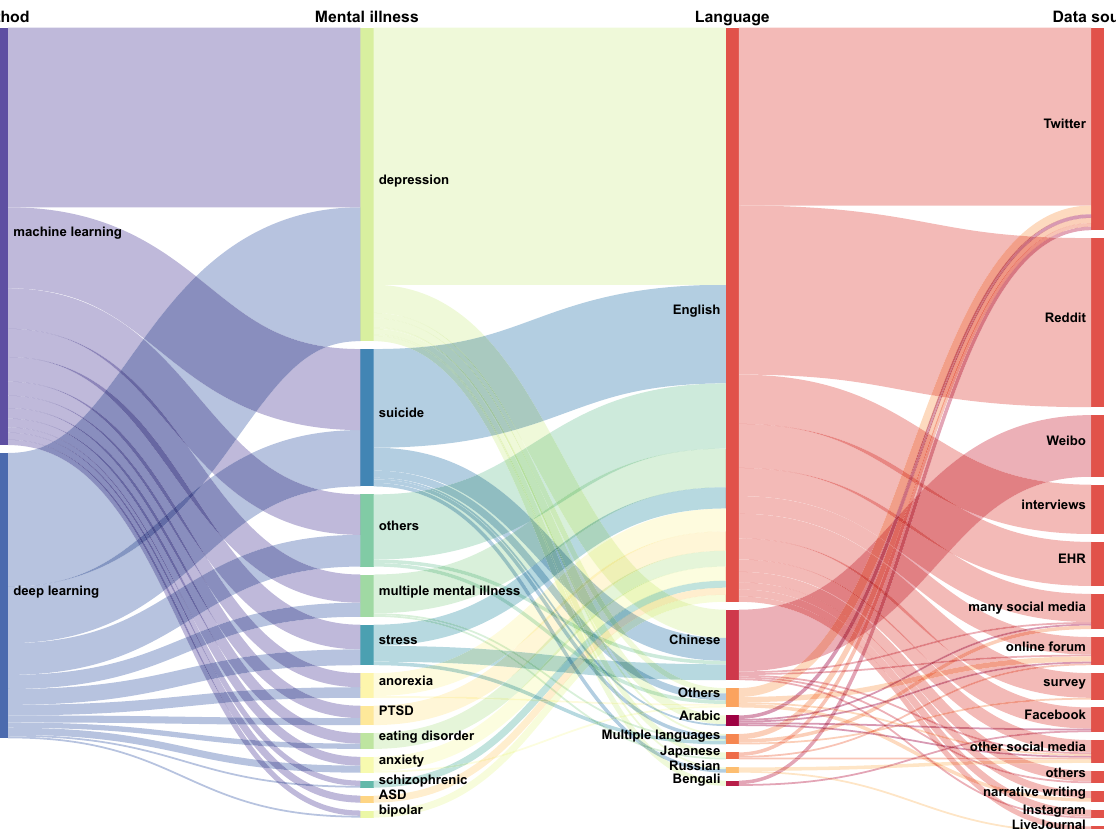
Fig. 3 Sankey diagram of NLP methods, illness, languages and applications. The different methods with their associated application are represented via fl ows. Nodes are represented as rectangles, and the height represents their value. The width of each curved line is proportional to their